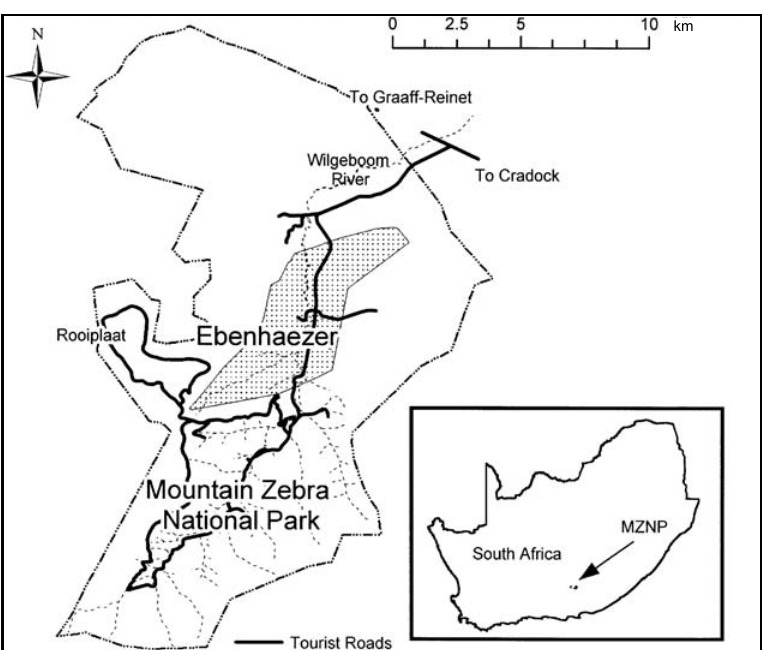
Fig. 1. Location of the study area in Mountain Zebra National Park (Compiled by S.